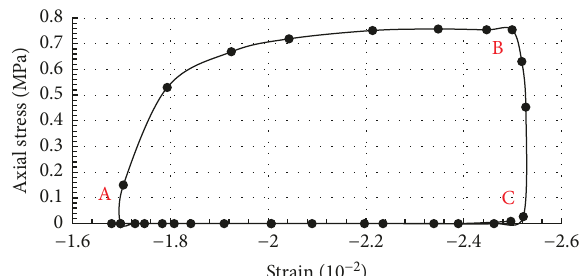
Figure 6: Detail drawing of the dynamic stress-strain path of artificial frozen soil (stage I).